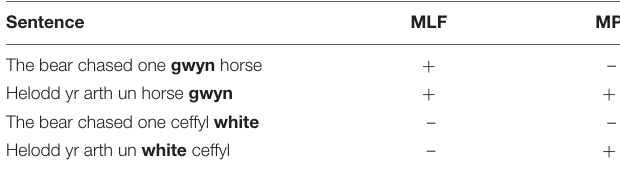
TABLE 1 | Example experimental sentences from Parafita Couto et al.